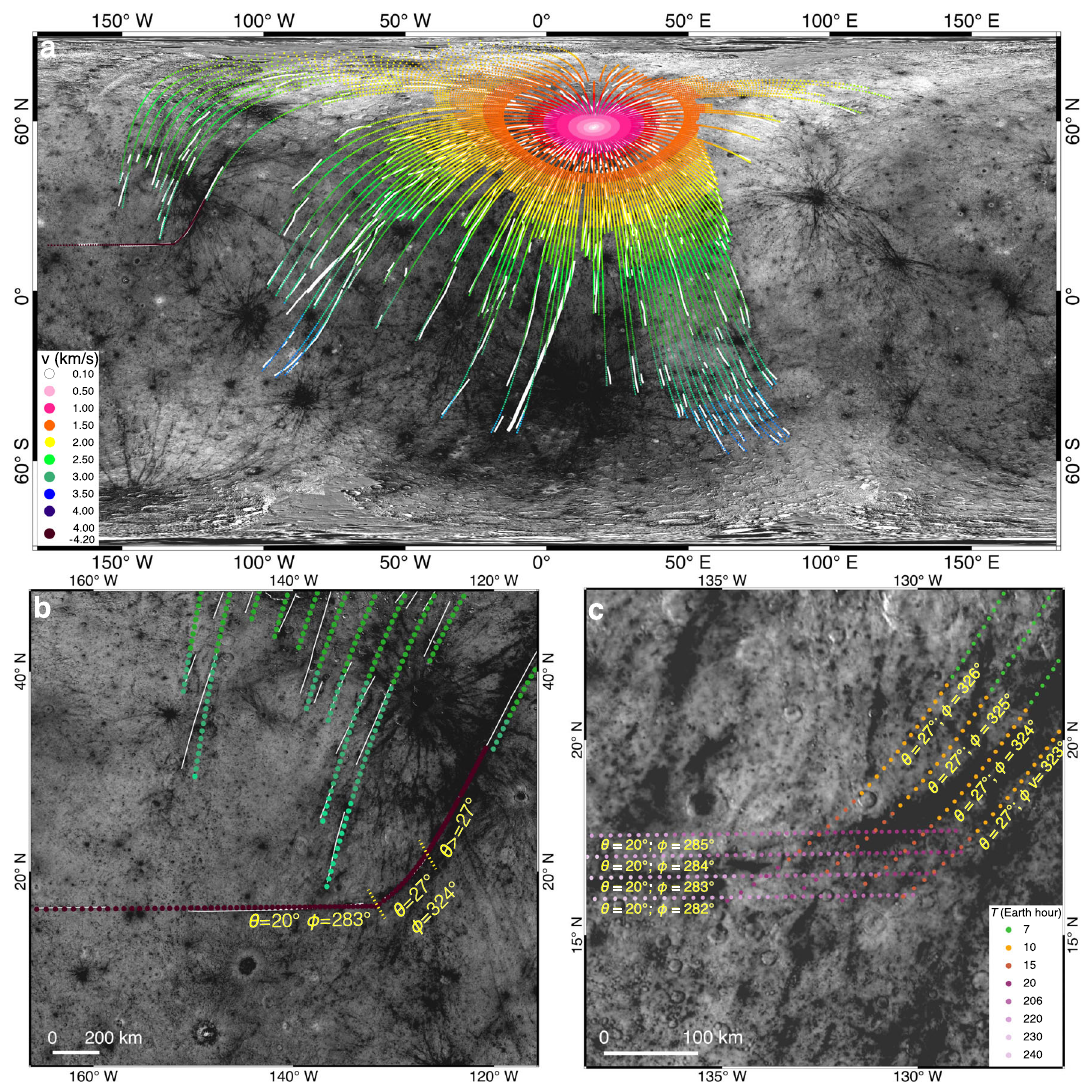
Fig. 4 | Best- fi t ejection conditions for Hokusai ’ s ejecta according to its visible impact rays. a Best- fi t ejection conditions as compared to the global ray system (white lines). Except for the curved ray in question, most rays are consistent with being formed by ejecta with uniform ejection angles of θ =35 – 55° (Supplementary Fig. 4). The reported case is based on θ =45°, excavation from the crater center of Hokusai, and the current rotational period of Mercury. Cases with the other exca- vation positions are reported in the Supplementary Figs. 3 – 4. Modeled ejecta particles are color-coded according to their ejection velocities. Bold white lines